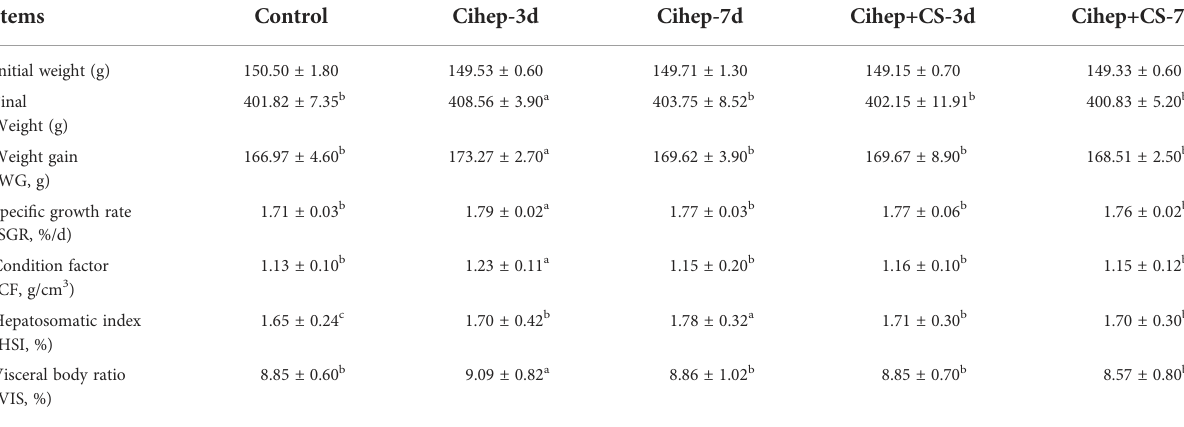
TABLE 3 Effects of dietary supplementation of Cihep and CS on growth performance of grass carp. Items